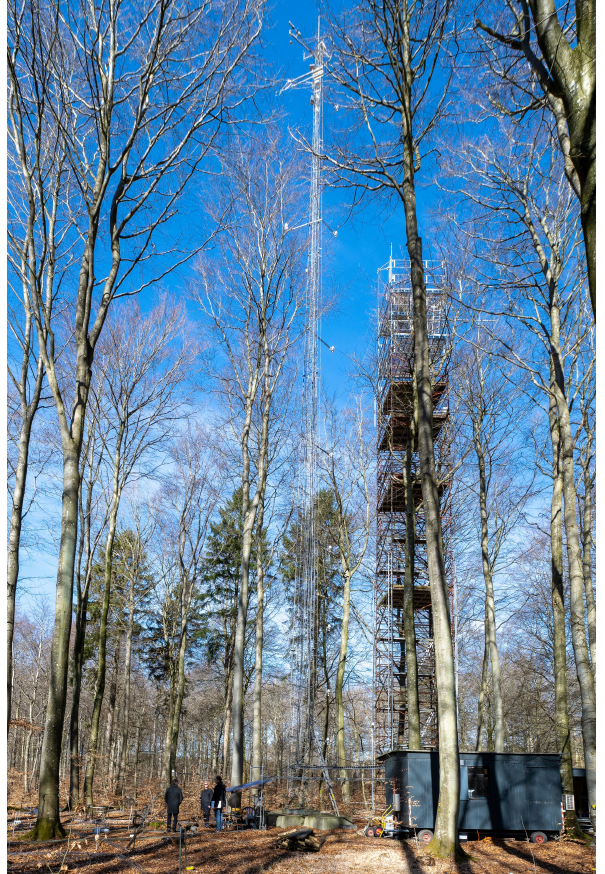
Figure 2. Photograph of the 45m mast and the nearby scaffolding tower at the DK-Sor beech forest site (photograph by Kim Pile- gaard).